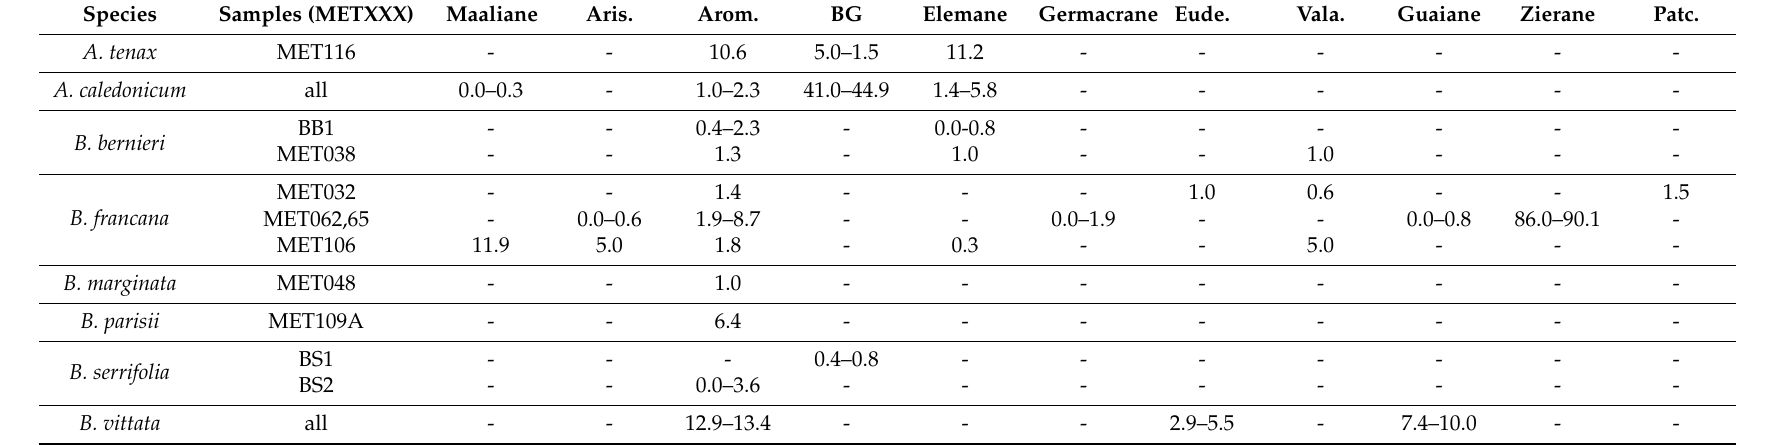
Table 4. Distribution of detected sesquiterpene types affiliated with the ( E-E )-germacradienyl cation (relative percentage,